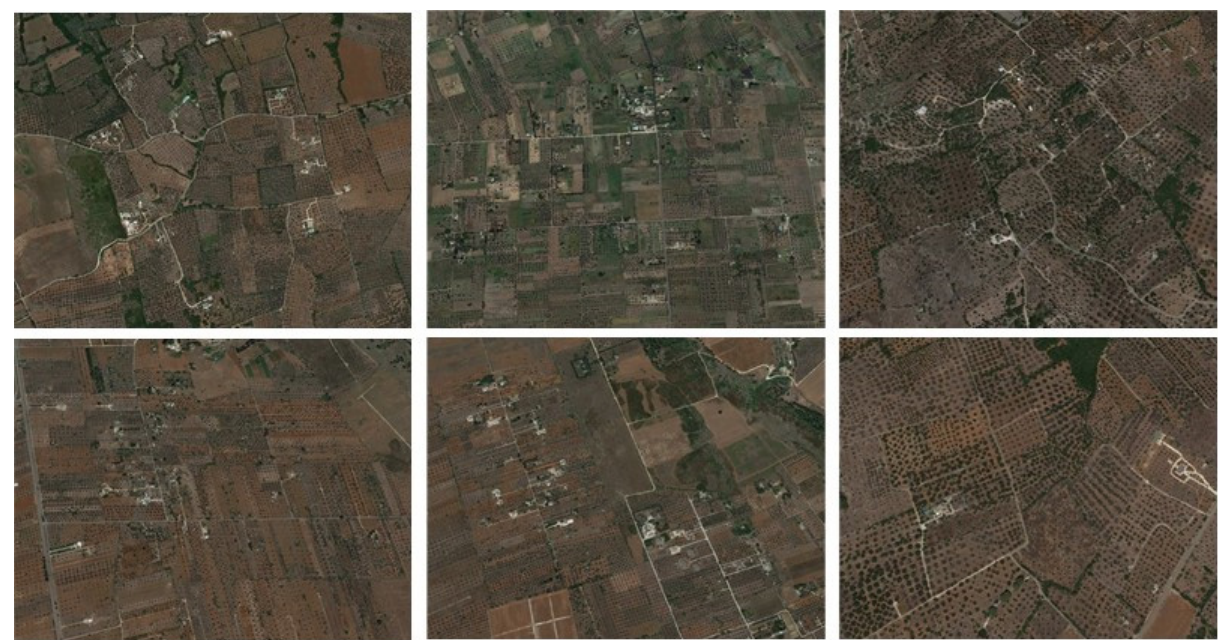
Figure 12. Example of a rural landscape with strong interaction between human settlements and olive groves.